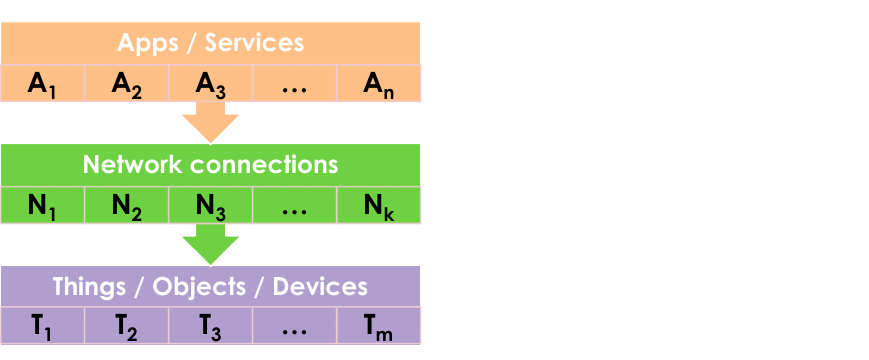
Figure 2. Schematic of the horizontal architectural design approach for the creation of IoT platforms.